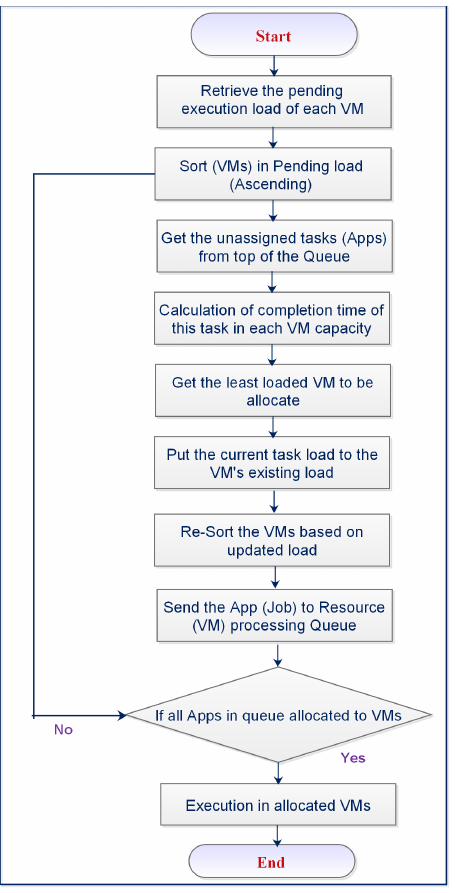
Figure 8. Dynamic scheduling at datacenter